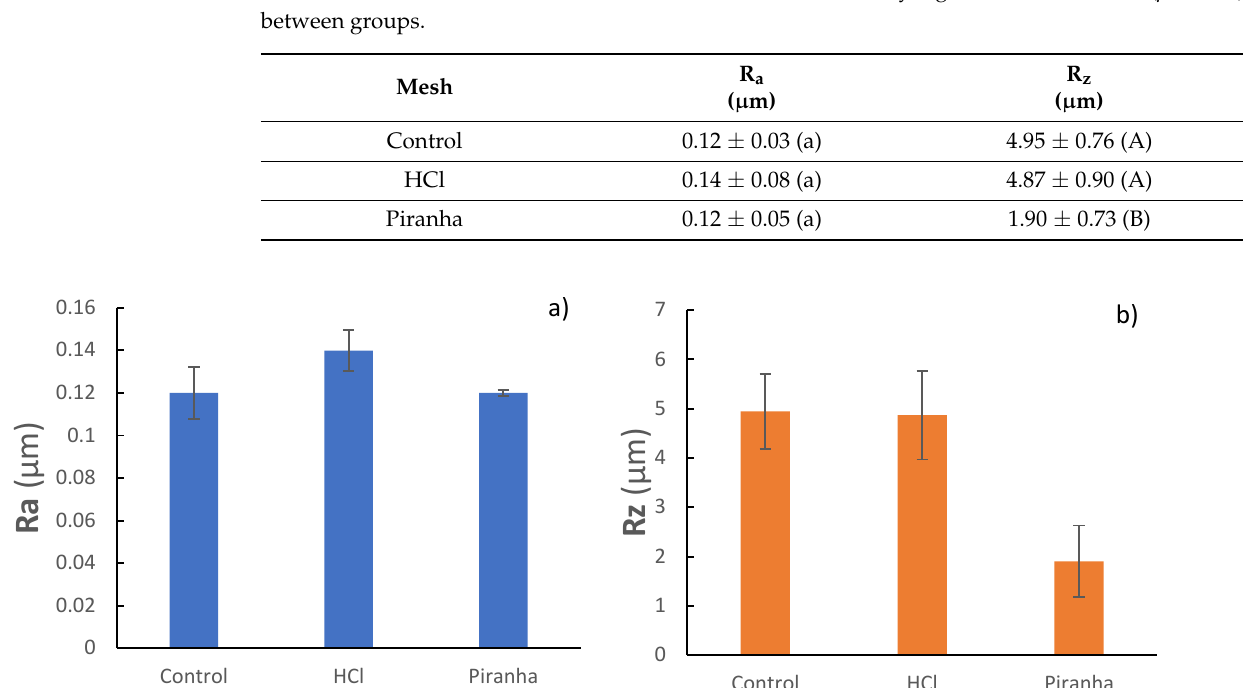
Figure 5. Roughness parameters quantified with different passivation conditions: ( a ) Ra and ( b ) Rz.